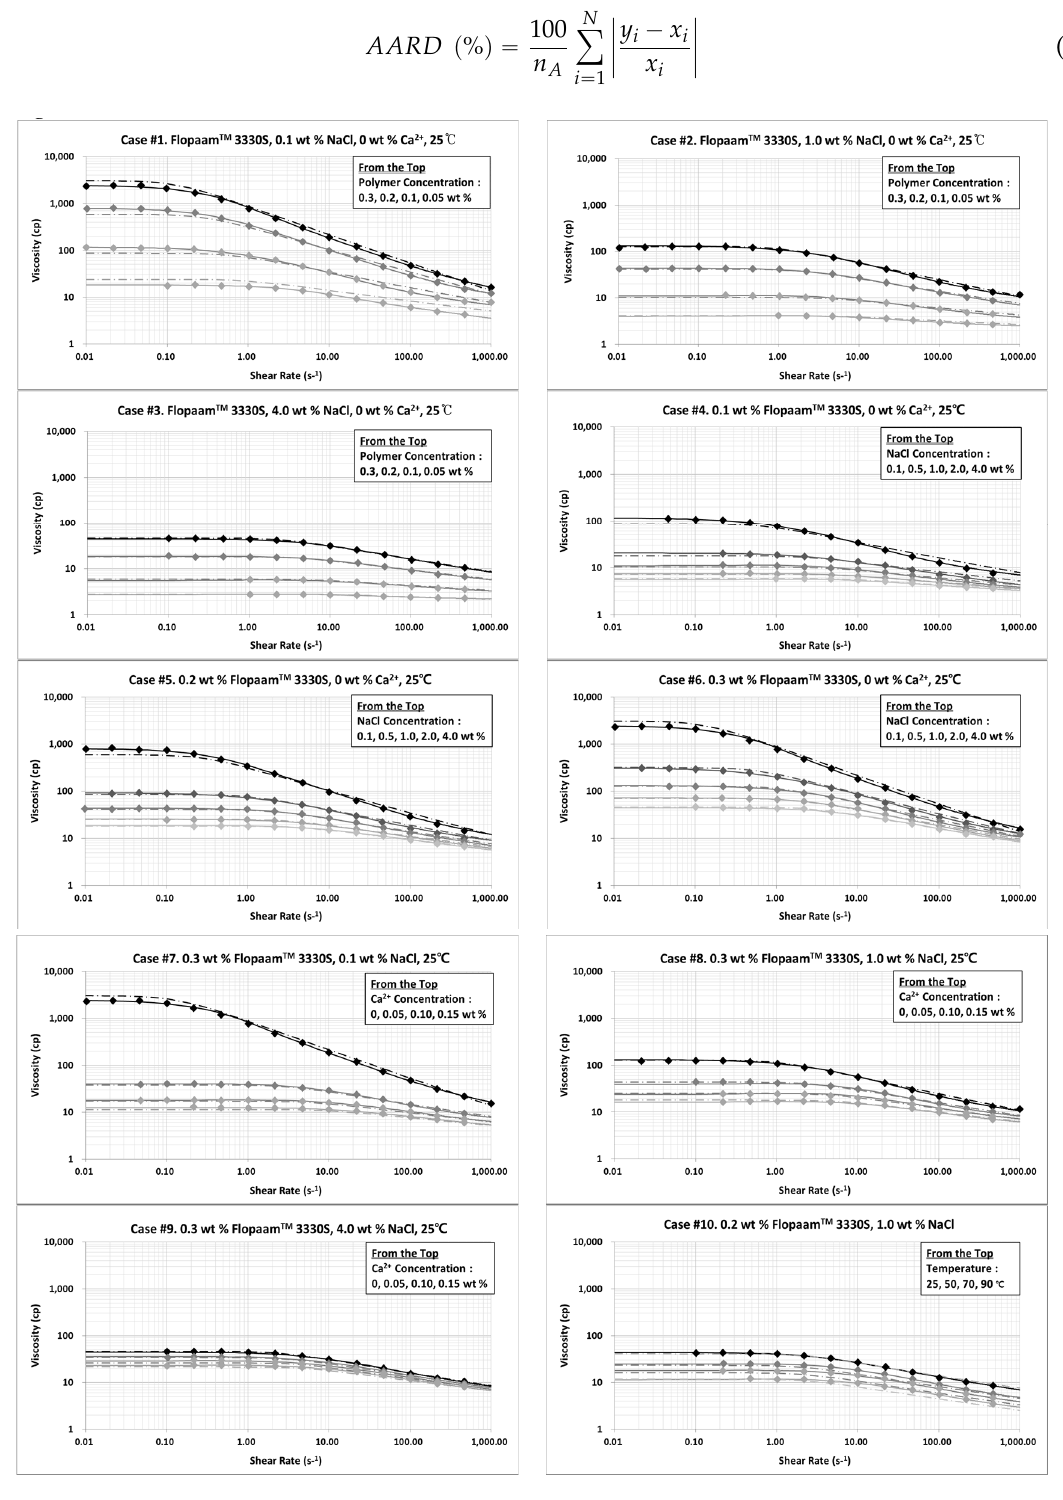
Figure 8. Comparison between the measured and estimated viscosities of Flopaam TM 3330S. Line, viscosity estimated by the ANN model; dot, measured viscosity; dotted line, viscosity estimated by the Carreau model using Lee’s correlation.